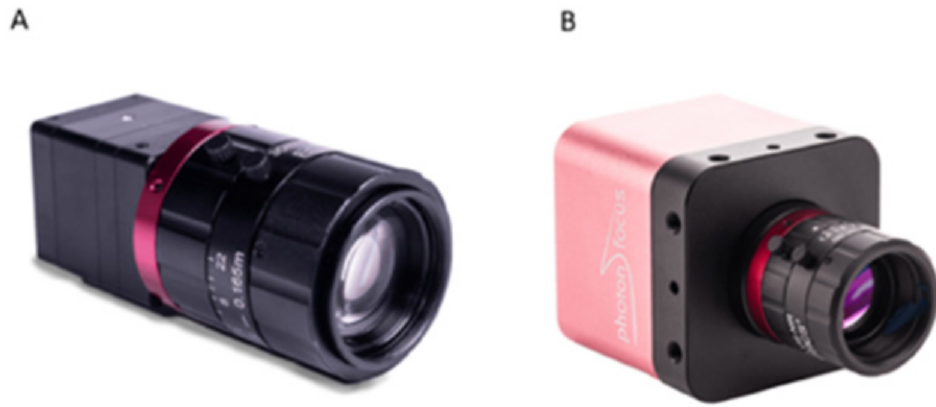
Figure 7. Images of the visible and NIR snapshot HSI cameras adopted. Options for camera integra- tion of the snapshot sensors include ( A ) a Ximea and ( B ) a PhotonFocus